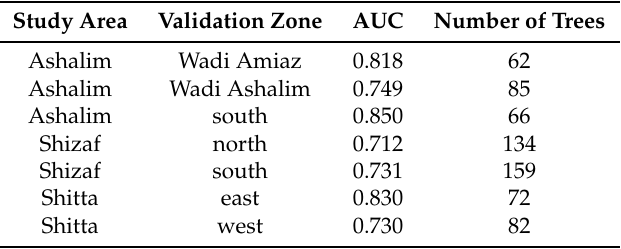
Table 3. Area under the curve (AUC) values and number of validation trees for all validation